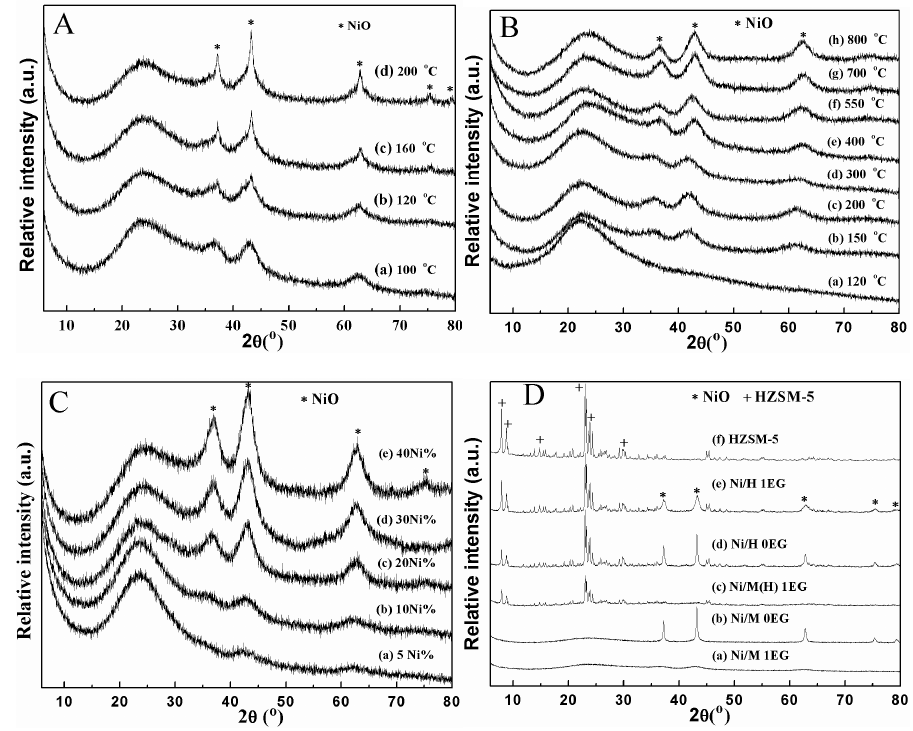
Figure 1. The effects of the synthesis parameters on the XRD patterns of various samples: ( A ) drying temperature; ( B ) calcination temperature (20 wt % Ni/M) and ( C ) Ni loading (5–40 wt % Ni/M) during co-impregnation with Ni/EG = 1:1; ( D ) 20 wt % Ni catalysts on different supports including MCM-41 and